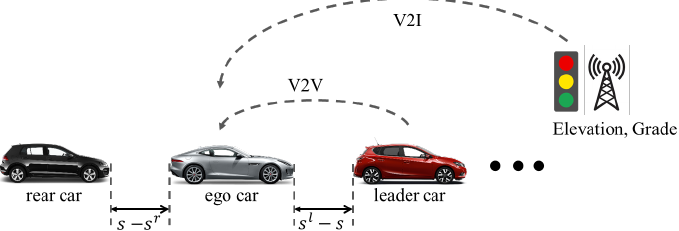
Figure 1. Increased levels of automation and connectivity through vehicle-to-everything (V2X)